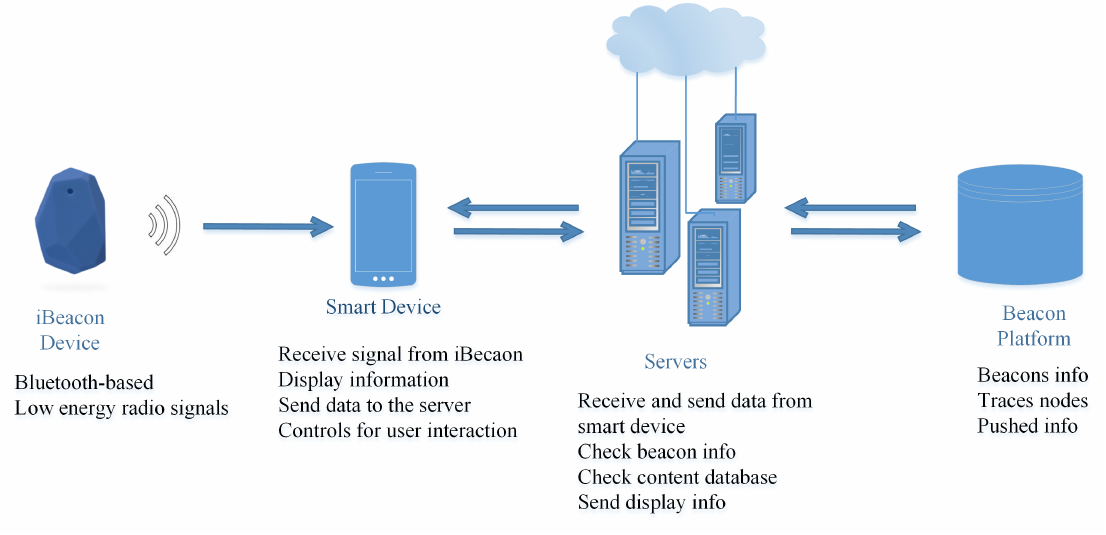
Figure 2. The architecture of beacon technology.